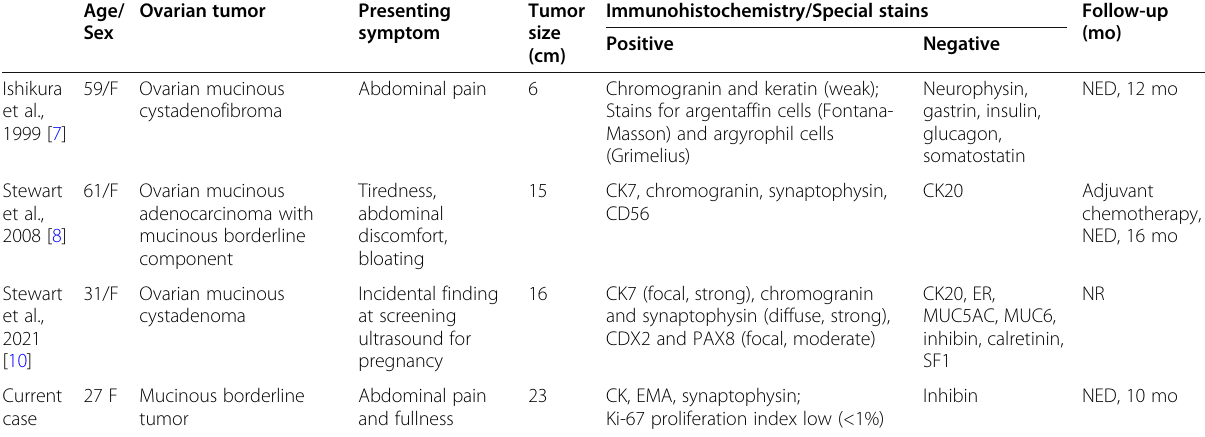
Table 1 Report of ovarian endocrine cell micronests: cases published between 1999 – present (including our case) Age/ Ovarian tumor Presenting Sex